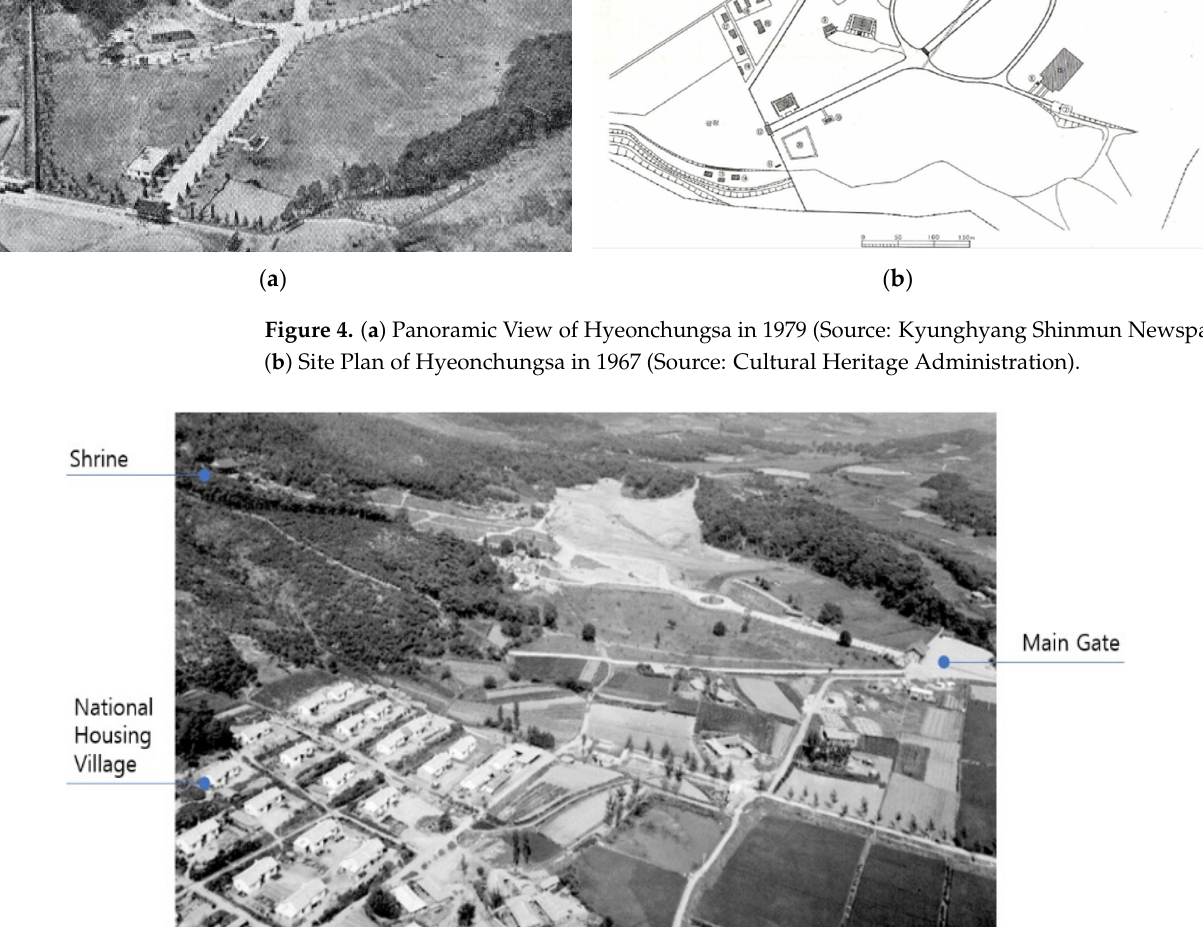
Figure 5. Aerial View of Hyeonchungsa Shrine and National Housing Village in 1968 (Source: National Archives of Korea).